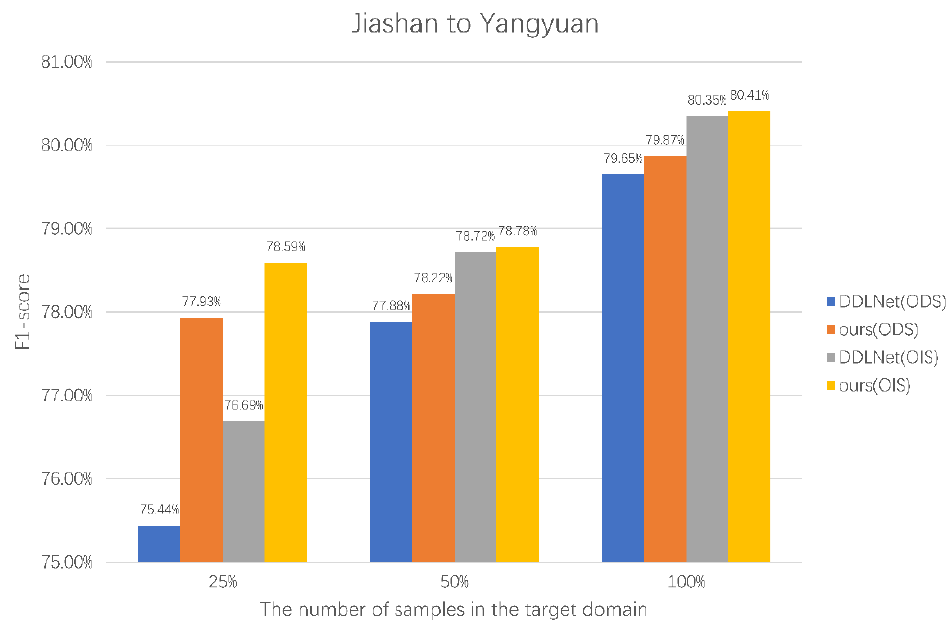
Figure 7. Comparison of experimental results between SEGOS and our method using different numbers of samples in Yangyuan County.